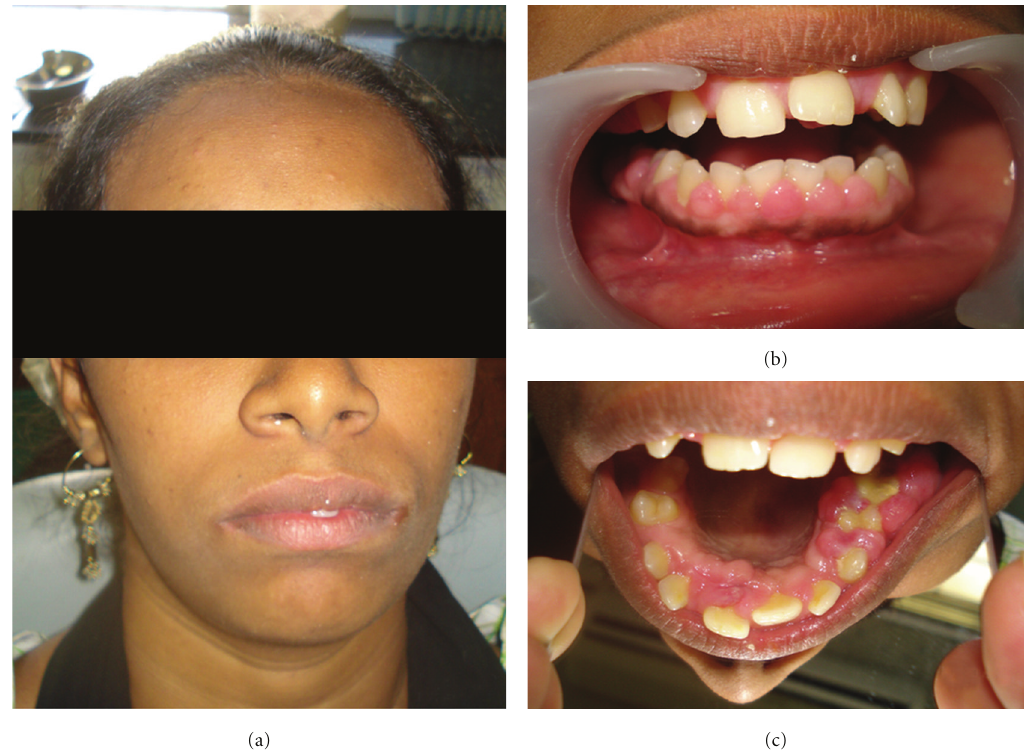
Figure 6: Showing patients sisters photograph, intraoral front view and upper mirror